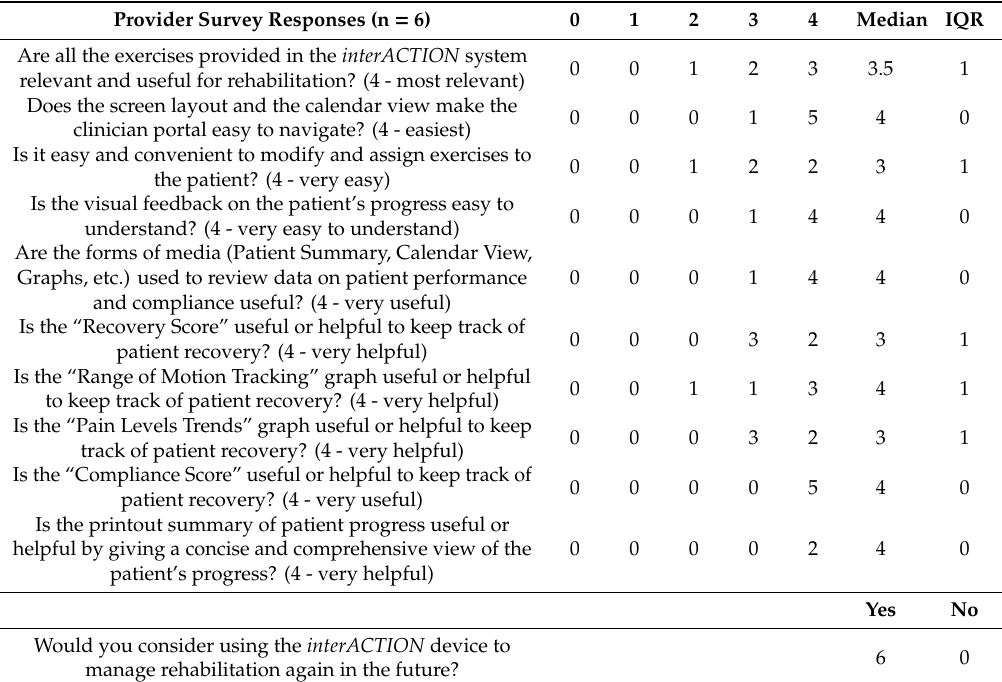
Table 6. Provider survey responses (n =